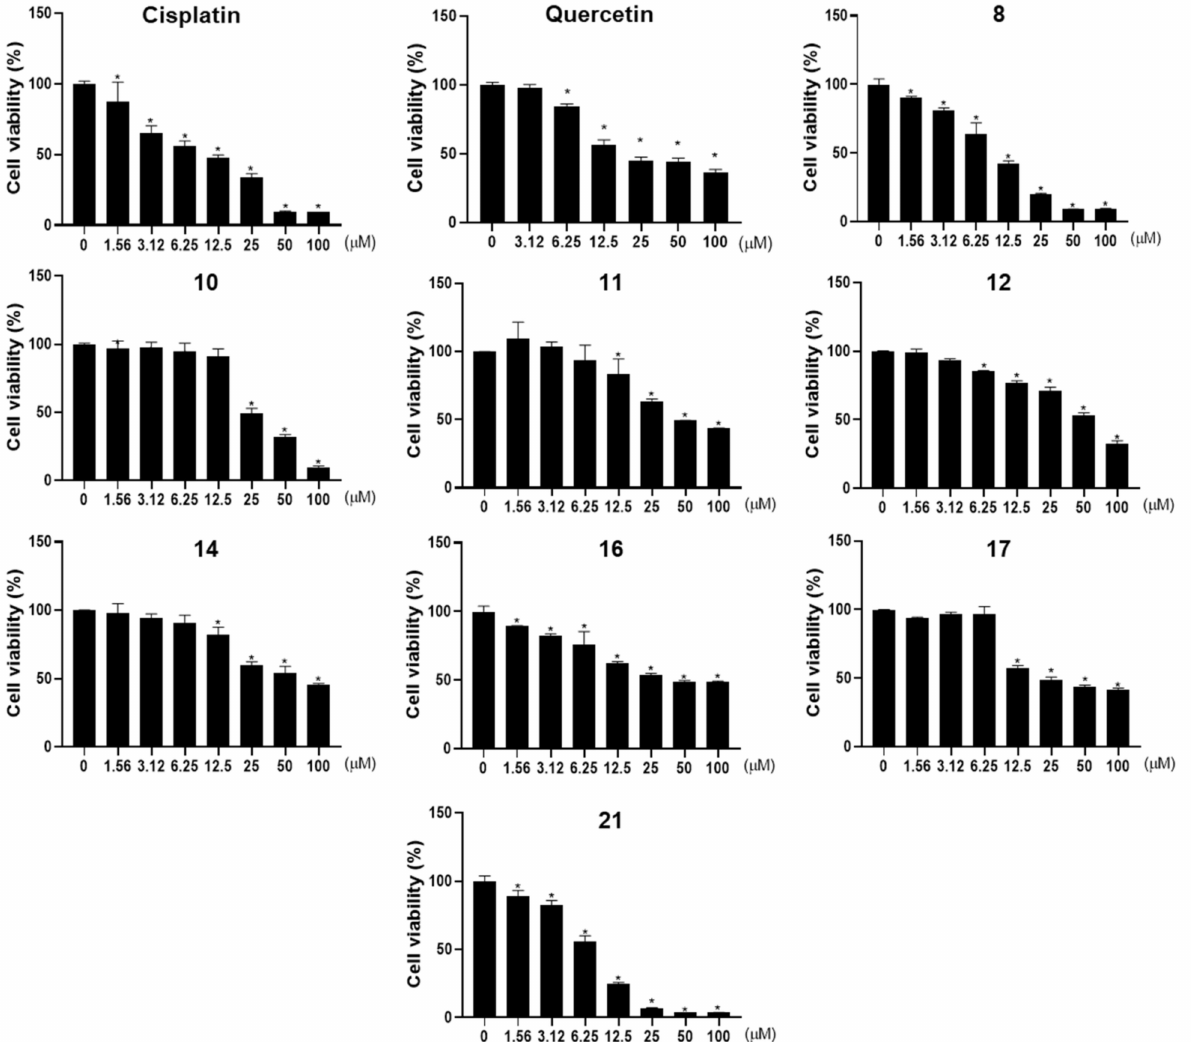
Table 3). Apigenin ( 8 ) and (-)-hydnocarpin ( 21 ) were the most active (IC 50 values of 9.99 and 7.36 µ M, respectively). In contrast, cisplatin, which is widely used as a first-line therapy in ovarian epithelial cancer, and quercetin, which is a well-known flavonoid to have anticancer activities, showed an IC 50 value of 10.73 and 19. 45 µ M, respectively. To further evaluate the effect of the compounds on the cell viability of non-malignant ovarian epithelial cells, we explored the cytotoxicity of the eight compounds ( 8 , 10 , 11 , 12 , 14 , 16 , 17 , and 21 ) against the immortalized human ovarian surface epithelial cell line IOSE80PC. (-)-Hydnocarpin ( 21 ) showed a mild cytotoxicity with an IC 50 value of 65.84 µ M against IOSE80PC cells and other seven compounds exhibited no activity (IC 50 >100 µ M) (Table 3). In contrast, cisplatin showed a similar cytotoxicity to IOSE80PC cells (IC 50 value of 12.78 µ M) as to A2780 cells (IC 50 value of 10.73 µ M).